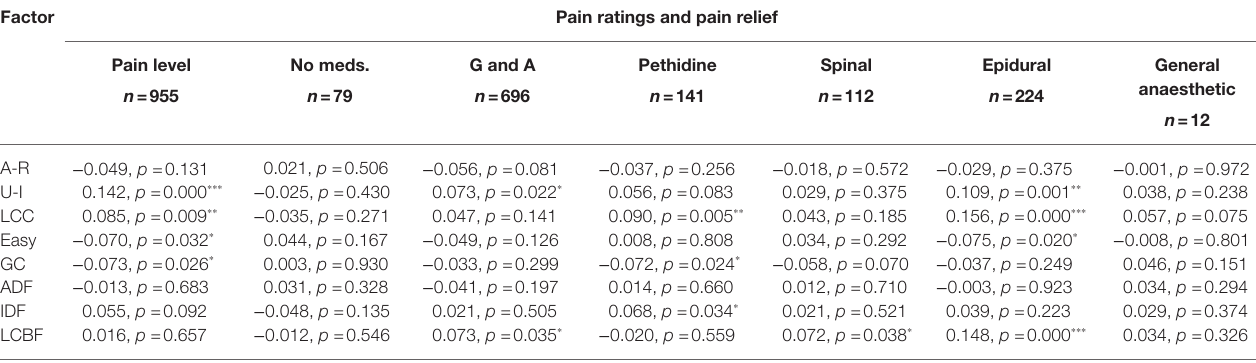
TABLE 6 | Pain ratings, pain relief and